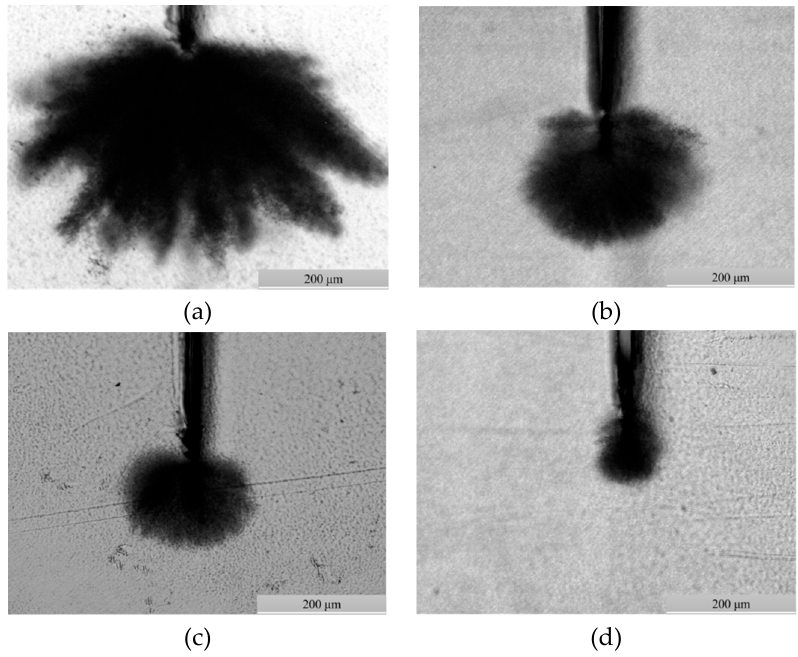
Figure 3. Water tree morphology of XLPE with different crosslinking degree: ( a ) XLPE-0 wt % BP, ( b ) XLPE-1 wt % BP, ( c ) XLPE-2 wt % BP and ( d ) XLPE-3 wt % BP.